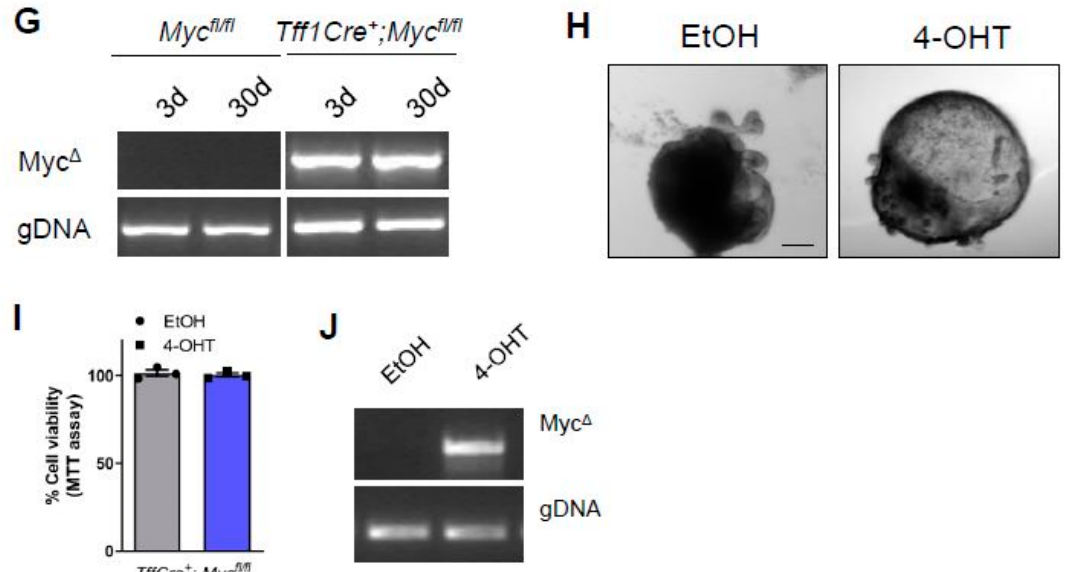
Figure 2. Conditional deletion of Myc from the gastric epithelium does not trigger epithelial repopulation . ( A ) X-gal stained tissue sections from Lgr5Cre + ; LacZ and Lgr5Cre + ; Myc fl/fl ; LacZ mice 3 and 30 days following tamoxifen. Scale bars = 100 μ m. ( B ) qRT-PCR for c -Myc on gastric epithelial cells isolated from Lgr5Cre + ; Myc +/+ and Lgr5Cre + ; Myc fl/fl mice following tamoxifen at 3 and 30 days post tamoxifen as indicated (* p < 0.05, mean ± SEM, n = 3 mice, Two-way ANOVA). ( C ) Representative IHC for GFP, which permits detection of Lgr5 GFP+ stem cells, on sections from mice described in A. Scale bars = 100 μ m. ( D ) Quantification of GFP + cells in sections from mice described in A (mean ±SEM, n = 3 mice, at least 30 glands scored/mouse, unpaired student t -test). ( E ) X-gal stained tissue sections from Tff1Cre + ; LacZ and Tff1Cre + ; Myc fl/fl ; LacZ mice 3 and 30 days following tamoxifen. Scale bars = 100 μ m. ( F ) qRT-PCR for c -Myc on gastric epithelial cells isolated from Tff1Cre - ;Myc fl/fl and Tff1Cre + ;Myc fl/fl mice following tamoxifen (* p < 0.05, mean ± SEM, n = 3 mice, two-way ANOVA). ( G ) Conventional PCR for recombined Myc (Myc Δ ) alleles in mice described in ( E ). ( H ) Representative DIC images of gastric organoids derived from Tff1Cre + ; Myc fl/fl mice 5 days after treatment with vehicle (EtOH) or tamoxifen (4-OHT). Scale bars = 100 μ m. ( I ) MTT viability assay performed on organoid cultures described in ( G ) (mean ±SEM, n = 3 biological replicates, unpaired student t -test). Individual experiments were repeated twice. ( J ) Conventional PCR for recombined Myc (Myc Δ ) alleles on organoid cultures described in ( H ).